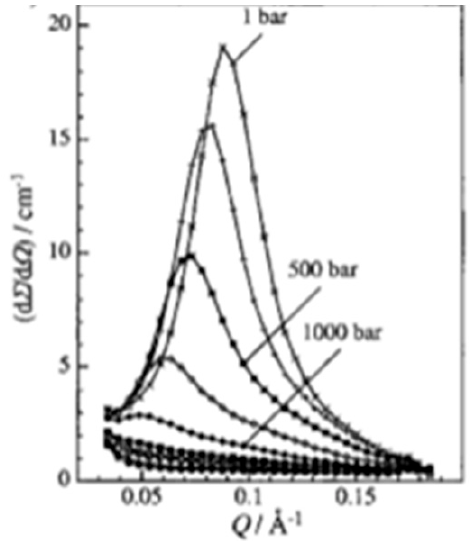
Figure 4. The effects of hydrostatic pressure on a micellar SDS solution as observed in a SANS experiment. At increased pressures, there is a continuous transformation from spherical to elongated micelles as evidenced by the gradual peak shift to lower angle. Figure provided by author [32].